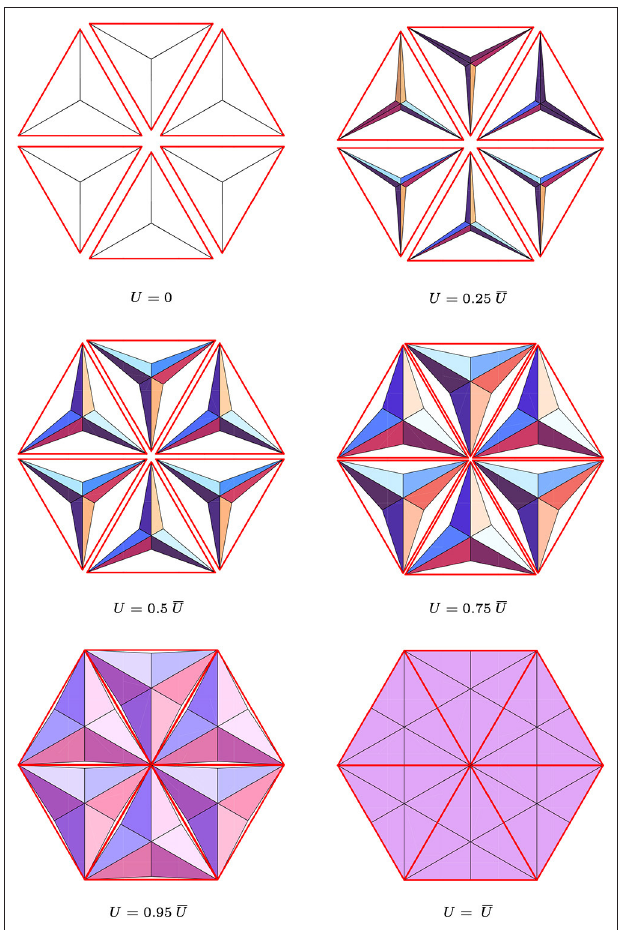
FIGURE 5 | Top views of different frames of the TABS actuation motion. (see the Supplementary Video for an animation of the TABS actuation).